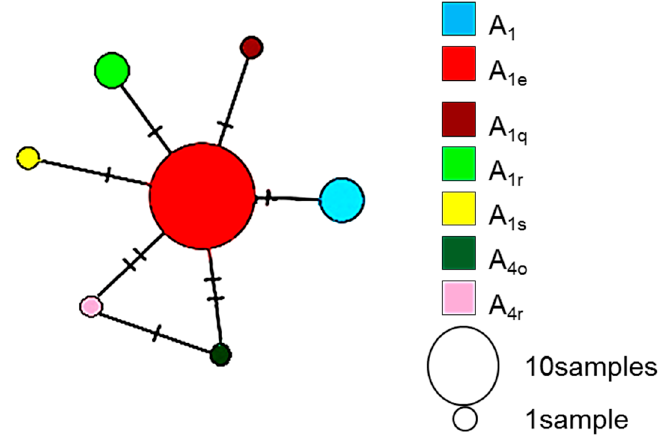
Figure 2. Haplotype network displaying the relationship between the mtDNA sequences of Apis mellifera L. samples collected from different localities in Cote d’Ivoire. Circle size represents the number of haplotype copies recorded in the dataset. Each hatch mark represents a nucleotide change.